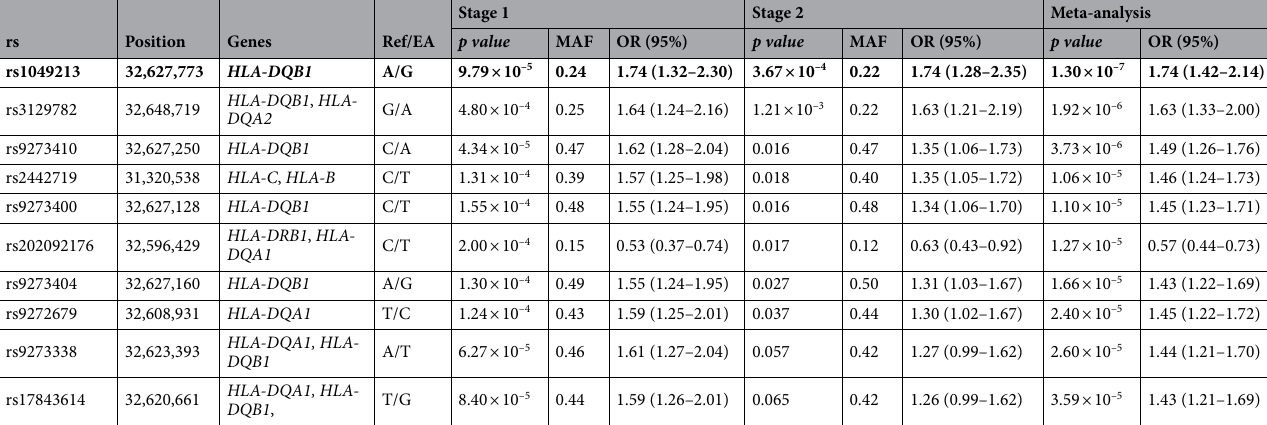
Table 2. Ten most significant variants after the meta-analysis of the targeted association. Association results from the 6p22.3-p21.32 region for stage 1, stage 2, and meta-analysis. Data were obtained using additive logistic regression models with EPACTS based on the Wald test. rs = single-nucleotide polymorphism (SNP) identification number; Ref = reference allele, EA = effect allele, MAF = minor allele frequency, OR = odds ratio. In bold, the variant that exceeds the threshold established by Bonferroni correction ( p = 1.20 × 10 –6 ) after the meta-analysis.